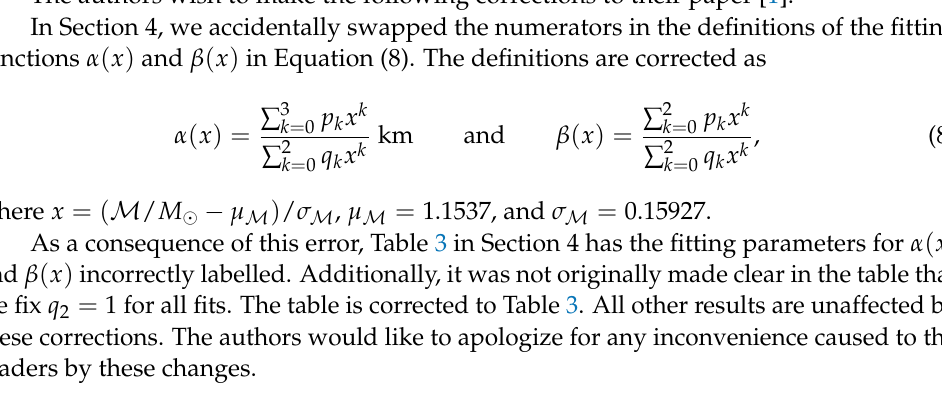
Table 3. Fitting parameters (cid:126) p = { p k } and (cid:126) q = { q k } for α and β as functions of x = ( M / M (cid:12)